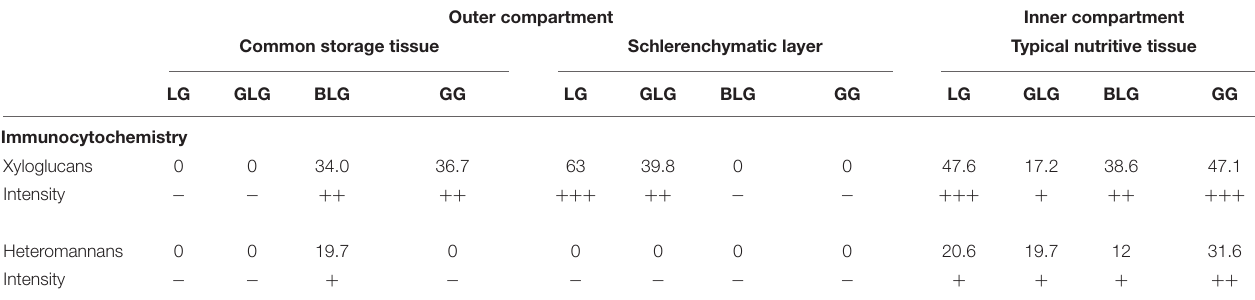
TABLE 2 | Average of gray value and intensity of reaction of the epitopes for hemicelluloses in the tissues of the four Lopesia galls on Mimosa gemmulata (Fabaceae). Outer compartment Inner compartment Common storage